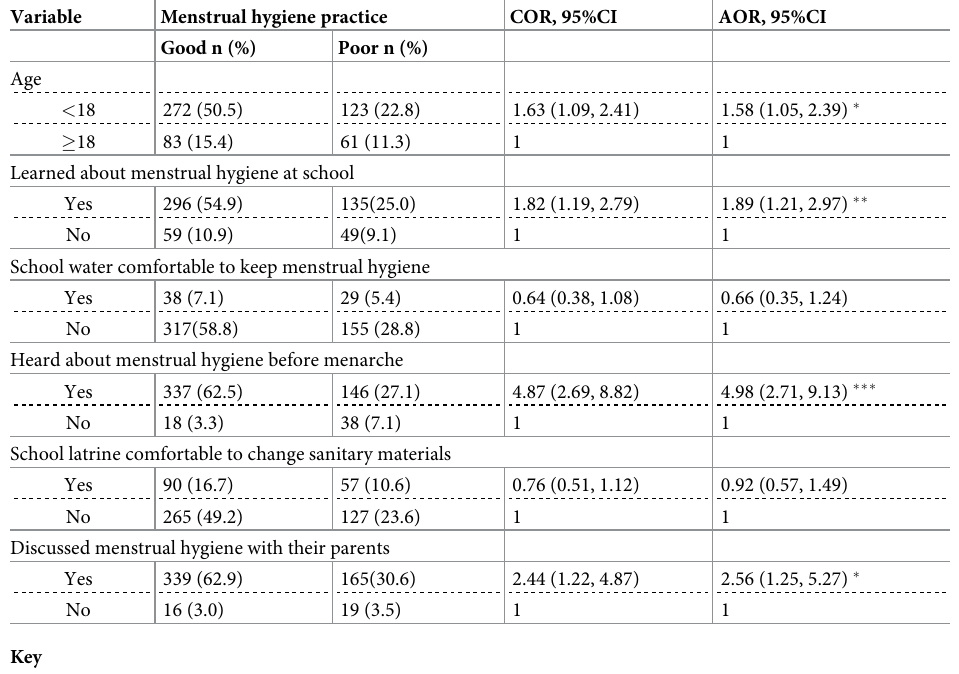
Table 4. Factors associated with menstrual hygiene management practice among urban schoolgirls in Northeast, Ethiopia, 2020 (n = 539).